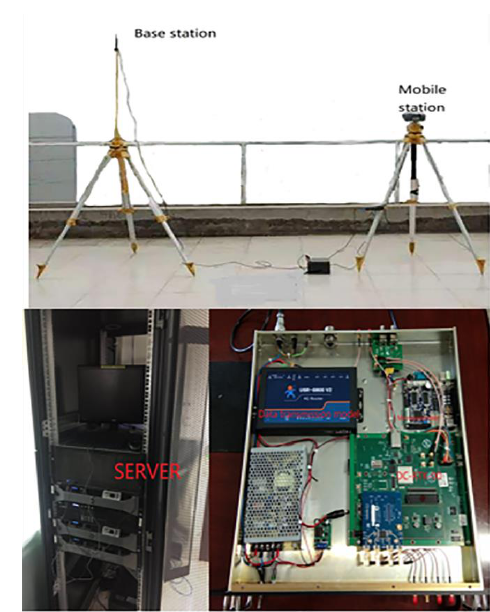
Figure 7. Scene map and physical device diagram.